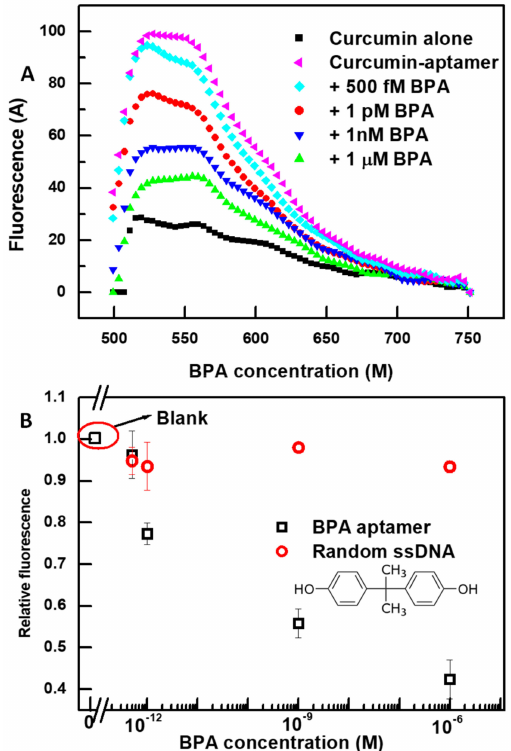
Figure 5. ( A ) Fluorescent spectra of the detection of BPA at increasing concentrations using the specific 75-mer BPA aptamer and the developed curcumin-based signal-o ff fluorescent sensor. The same conditions of VTD3 sensors were used in this case: 0.6 µ M of curcumin, 100 nM of BPA aptamer, and detection in 0.1 mM NaCl solution. ( B ) Di ff erential change in fluorescence (relative fluorescence) versus the concentration of BPA. The response towards BPA is also shown for a control experiment with a random 70-mer ssDNA. Error bars represent standard deviations from two